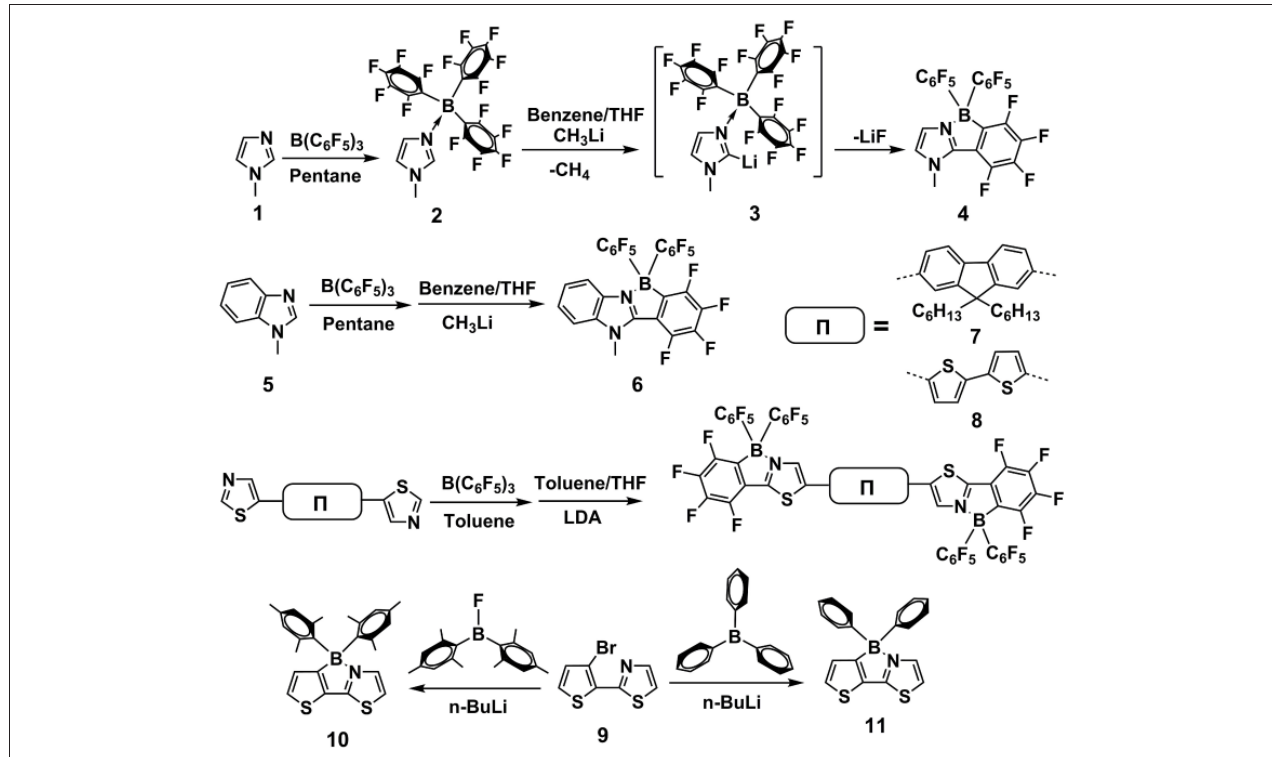
FIGURE 3 | Examples of synthesis routes toward B ← N embedded units involving alkyl lithium / aryl boron reaction